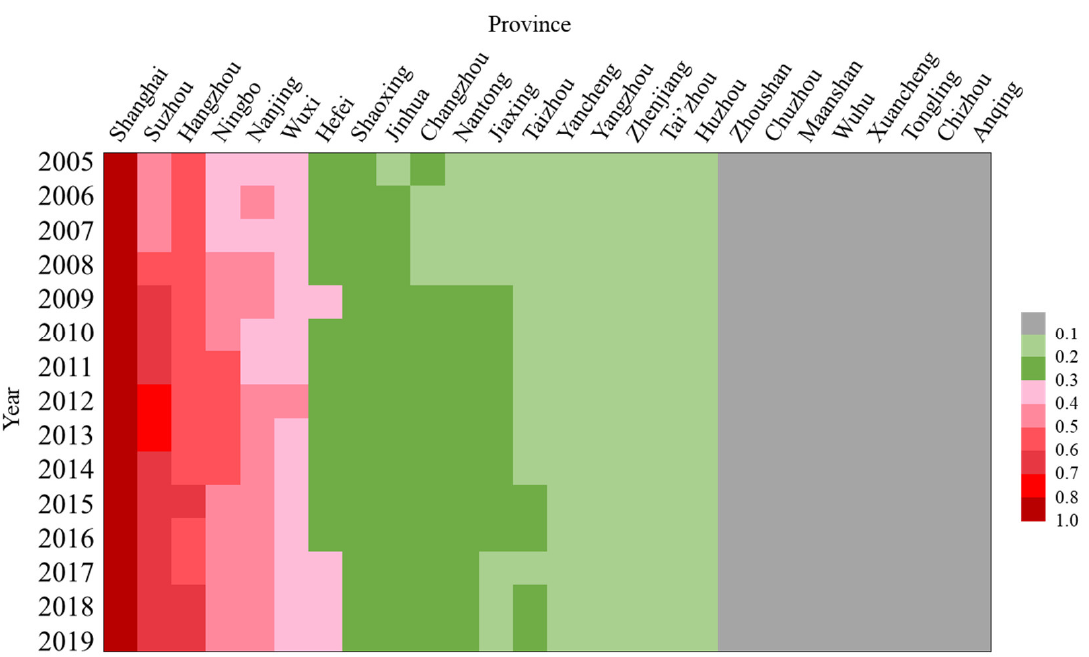
Figure 4. The interconnectivity of cities in the YRDUA.